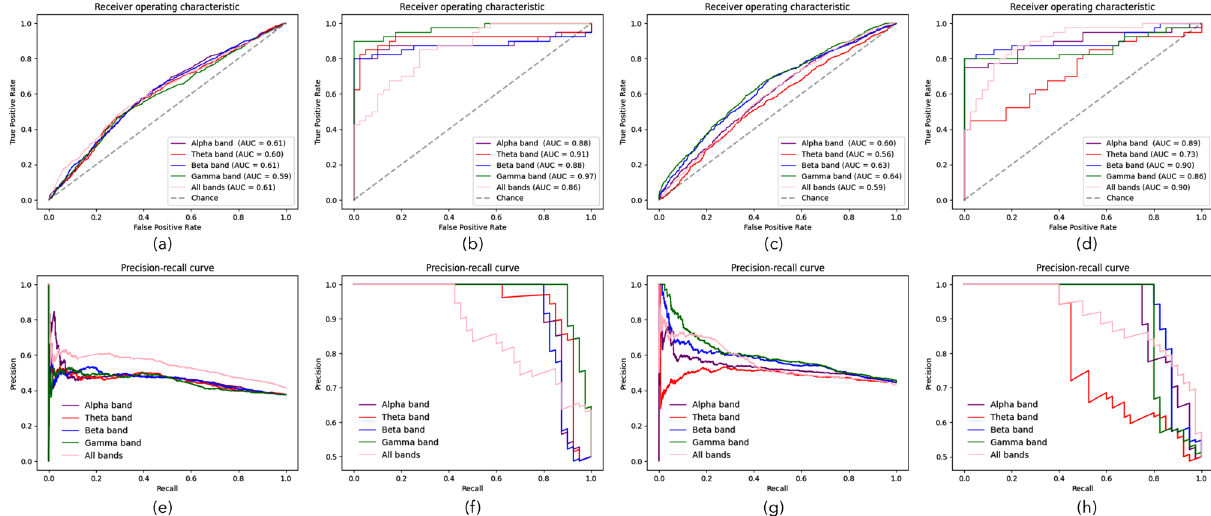
Figure 6. ROC and PR curve of arousal/valence emotion prediction based on individual and group PLV: ( a ),( e ) arousal emotion prediction based on individual PLVs, ( b ),( f ) arousal emotion prediction based on group PLVs, ( c ),( g ) valence emotion prediction based on individual PLVs, ( d ),( h ) valence emotion prediction based on groups